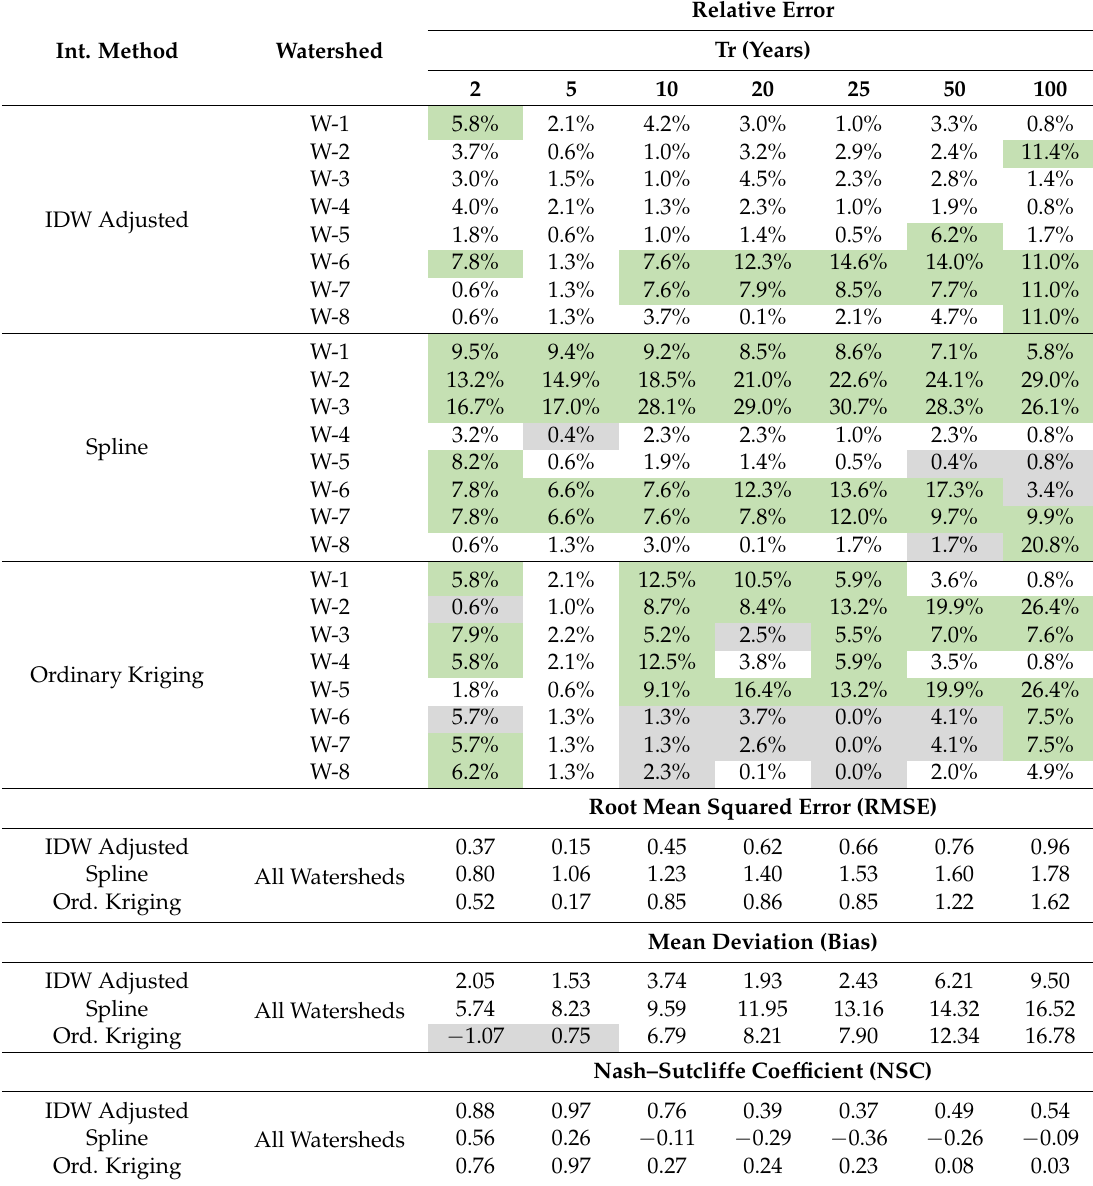
Table 9. Interpolation method performance at each watershed.